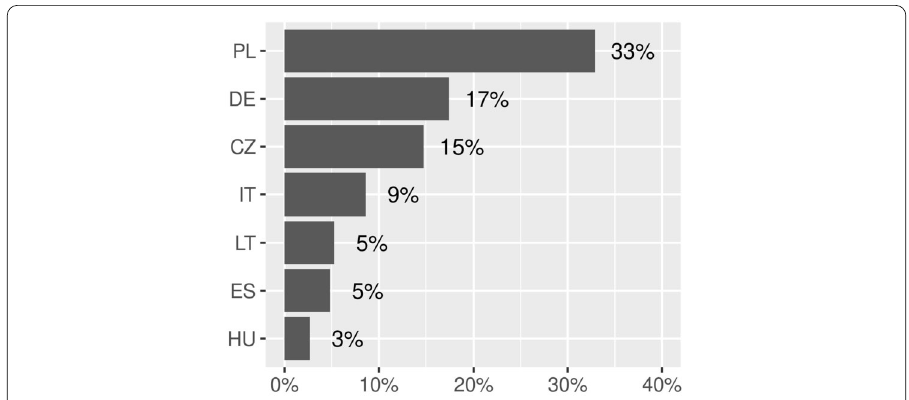
significant increments (> 2%) are shown